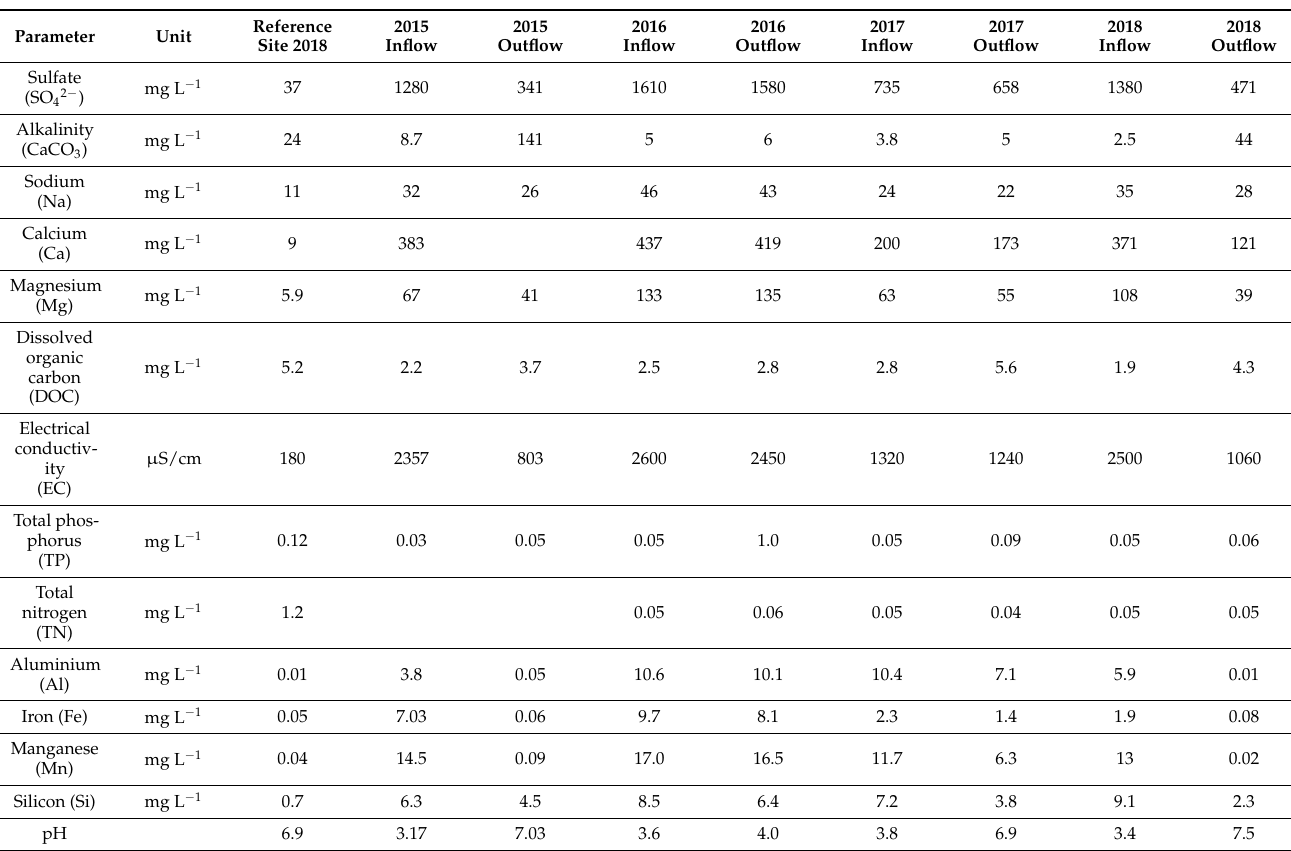
Table 3. Average chemical and physical parameters measured during the sampling period of 2015– 2018 at the inflow and outflow of the wetland ( n = 16).